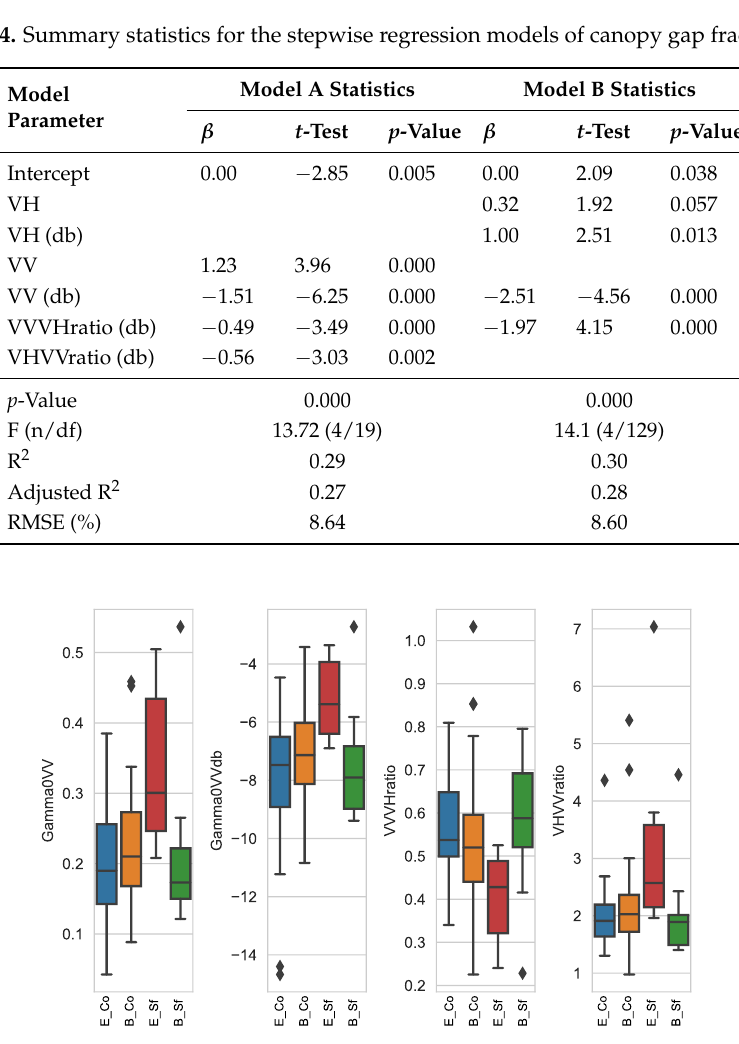
Figure 7. Boxplot distribution of significant predictors in model A, for the 4 land use categories (a combination of site and land use) (Figure 4a).